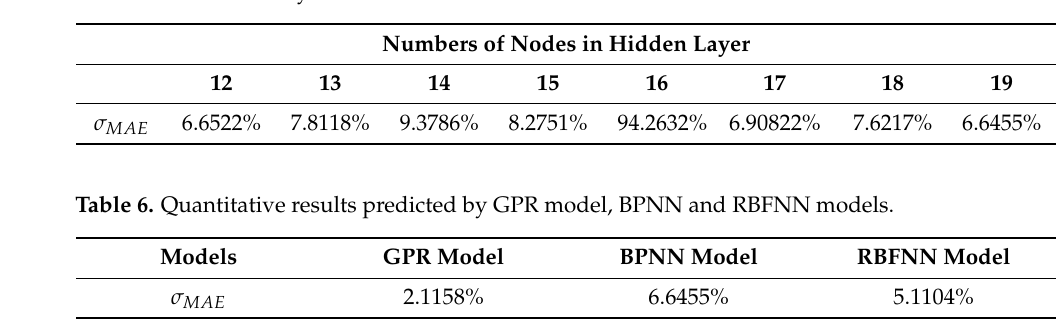
Figure 5. The prediction results of different models, ( a ) Gaussian process regression (GPR) model, ( b ) BPNN model, ( c ) radial basis function neural network (RBFNN) model. Table 6. Quantitative results predicted by GPR model, BPNN and RBFNN models. Table 5. The back propagation neural network (BPNN) model performance of different numbers of nodes in the hidden layer.